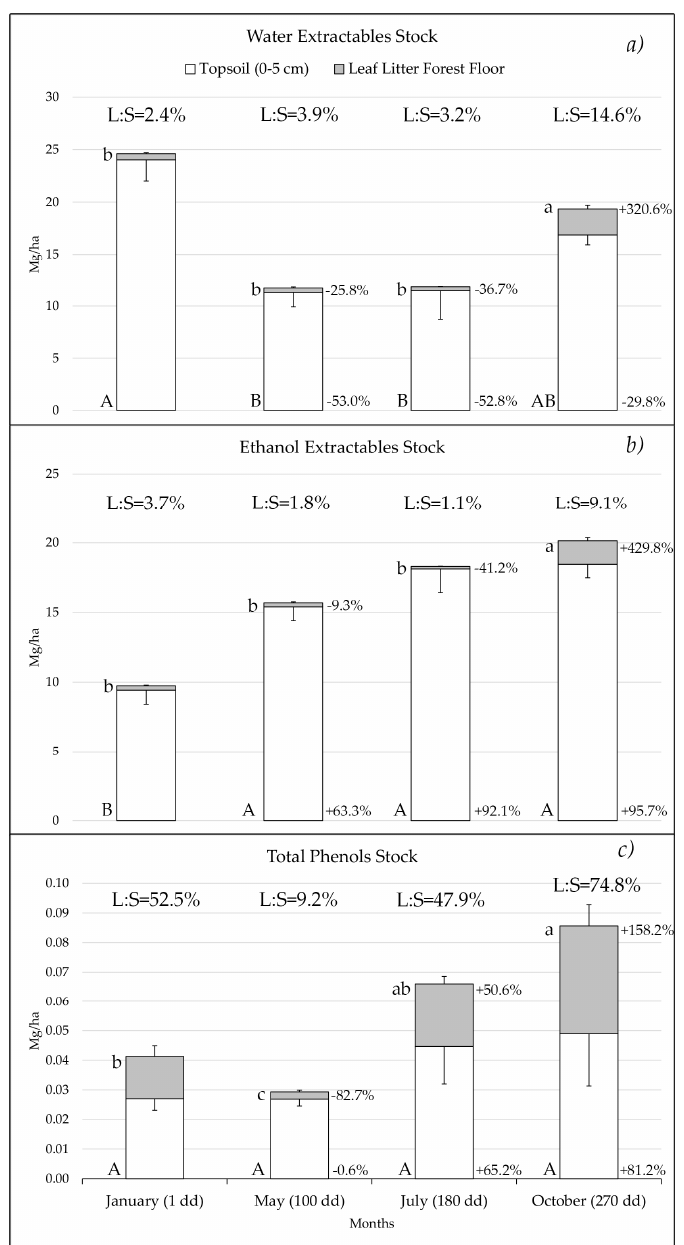
Figure 3. Dynamics of water extractable ( a ), ethanol extractable ( b ) and total phenol ( c ) stocks in the forest floor leaf litter (upper grey bars) and topsoil (lower white bars). Each bar is accompanied by the relative increase or decrease in the stock compared to January. The presence of significant differences between sampling per compartment was tested by the mean of a one-way ANOVA followed by a Tukey post-hoc test. Such differences are shown as lowercase letters for forest floor leaf litter and uppercase letters for topsoil. Bars which do not share a letter have significant differences ( p < 0.05). At the top of each graph, the ratio between the stocks in the forest floor leaf litter and topsoil is shown. Months and decomposition days (dd, in parentheses) in the litterbag experiment are reported. L:S indicates the ratio between the stock in leaf litter forest floor and the topsoil.